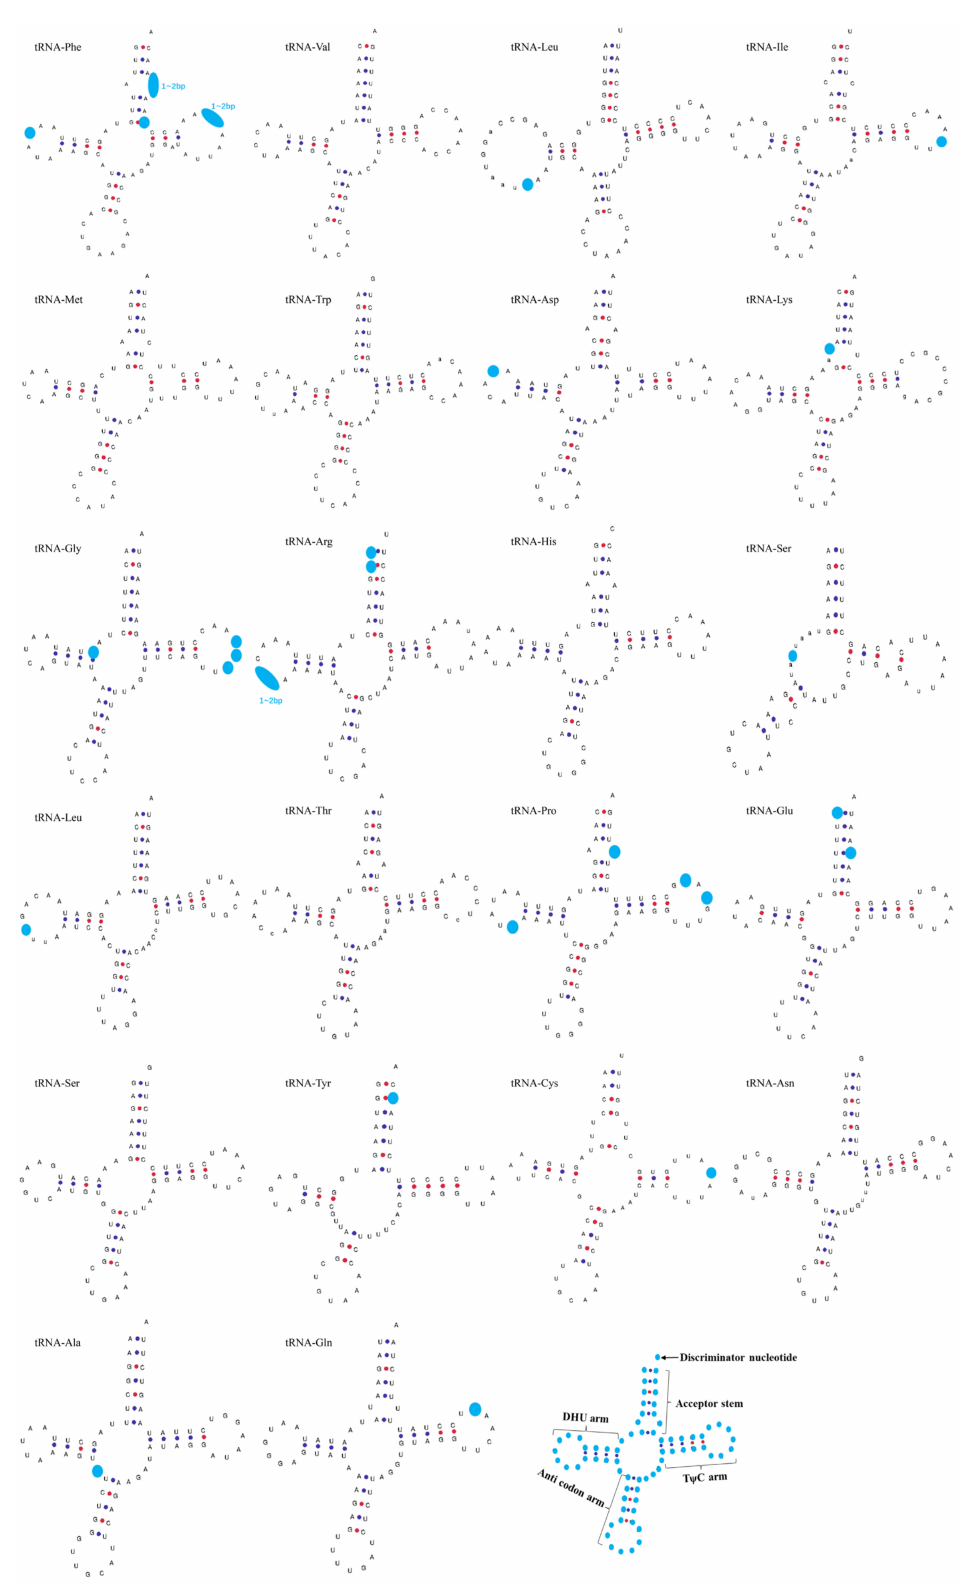
Figure 6. Secondary structures of 22 transfer RNAs (tRNAs) indicating the structural variation among the four P. sinensis strains . The light blue dots indicate variation sites in the tRNA sec- ondary